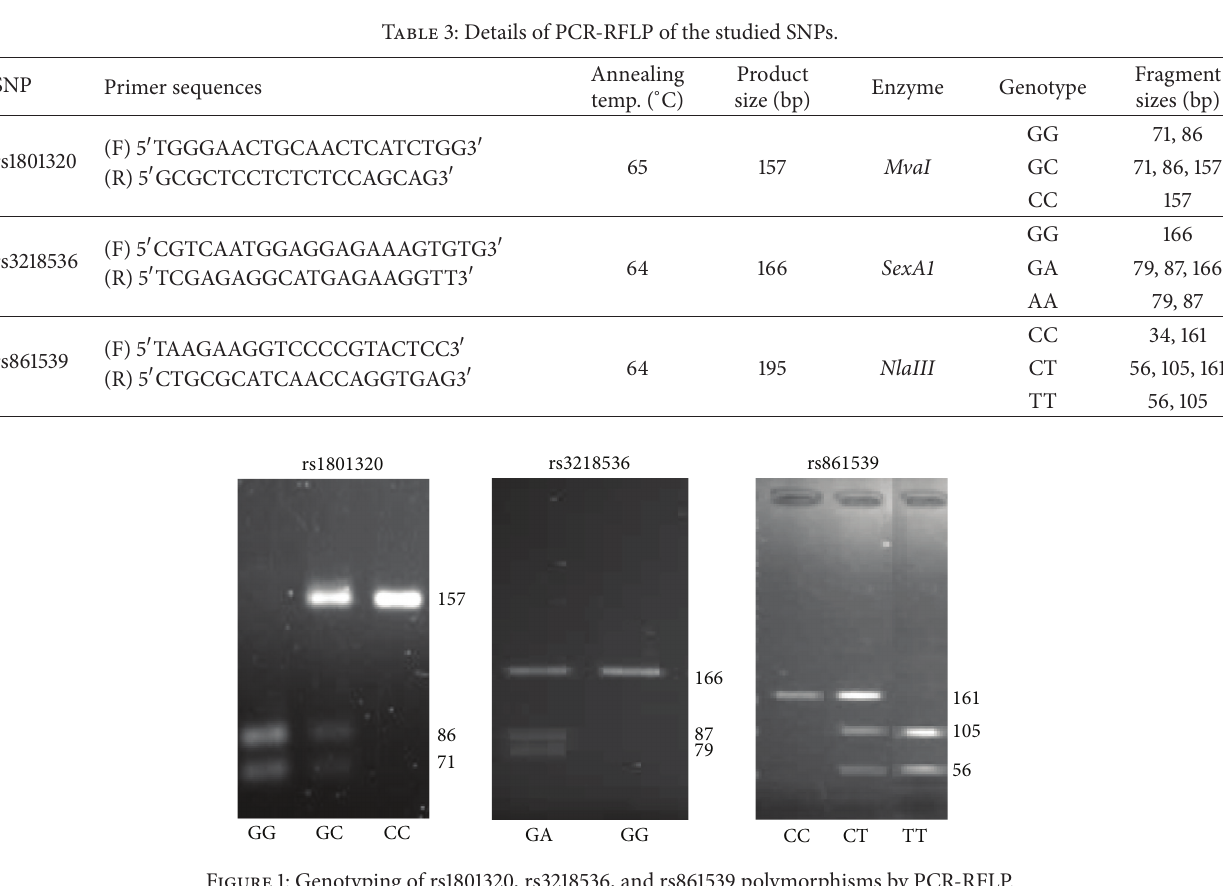
Figure 1: Genotyping of rs1801320, rs3218536, and rs861539 polymorphisms by